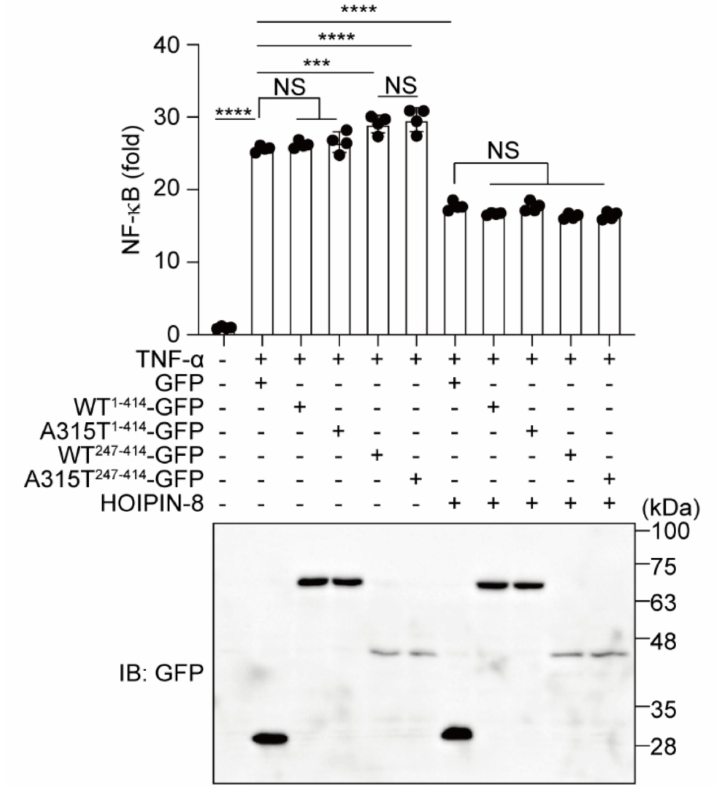
Figure 7. HOIPIN-8 suppresses the increased NF- κ B activity by truncated TDP-43. Neuro2a cells transfected with the NF- κ B luciferase reporter, WT 1-414 -GFP-, A315T 1-414 -GFP-, WT 247-414 -GFP, or A315T 247-414 -GFP with LUBAC were treated with 100 ng/mL TNF- α for 6 h, and as indicated, cells were pretreated with 10 µ M HOIPIN-8 for 1 h before the TNF- α treatment. The luciferase activities were then analyzed. Data are shown as mean ± SEM, n = 4. One-way ANOVA was followed by a post hoc Tukey HSD test. ***: p < 0.001, ****: p < 0.0001, NS—not